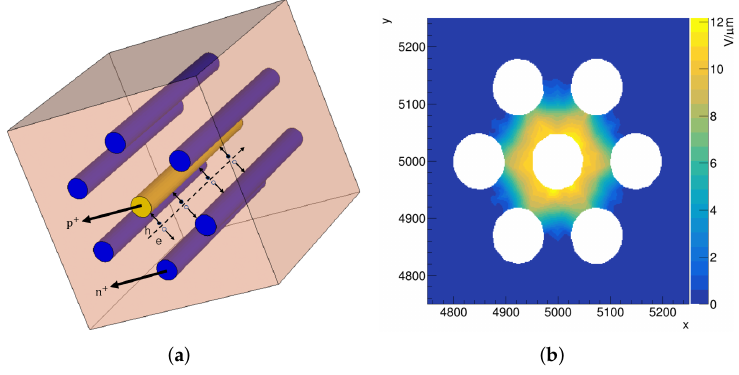
Figure 2. ( a ) 3D 4H-SiC detector schematic diagram. ( b ) The electric field distribution of x–y cross section for the 3D 4H-SiC detector with 500 V bias voltage simulated with